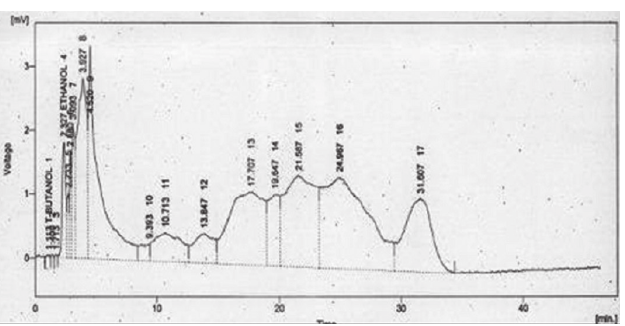
FIGURE 1 - HPLC chromatogram of aqueous extract of Sigesbeckia orientalis . Where peak 7 = quercetin, peak 9 = gallic acid, peak 12 = vanillic acid, peak 13 = p-coumeric acid, peak 14 = m-coumeric acid and peak 16 = cinamic